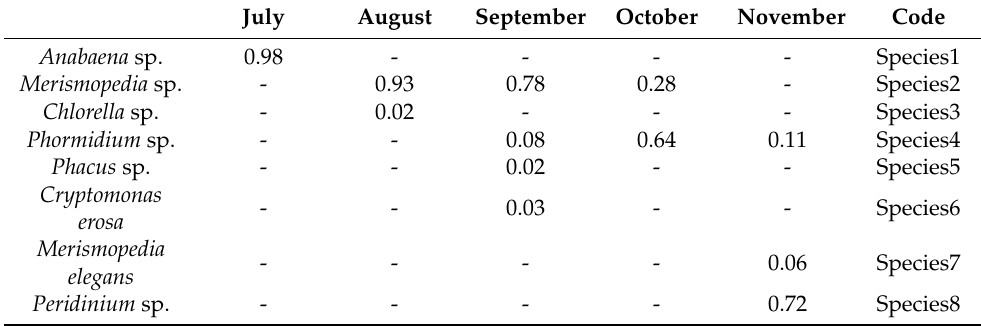
Table 4. Dominant species and their dominance in the water surrounding the artificial